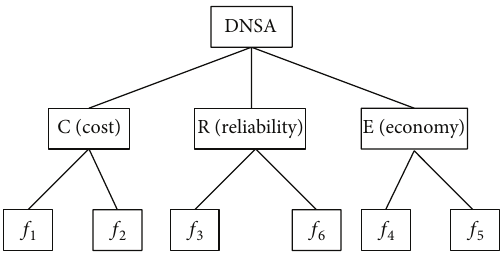
Figure 1: The hierarchy model of the first kind.